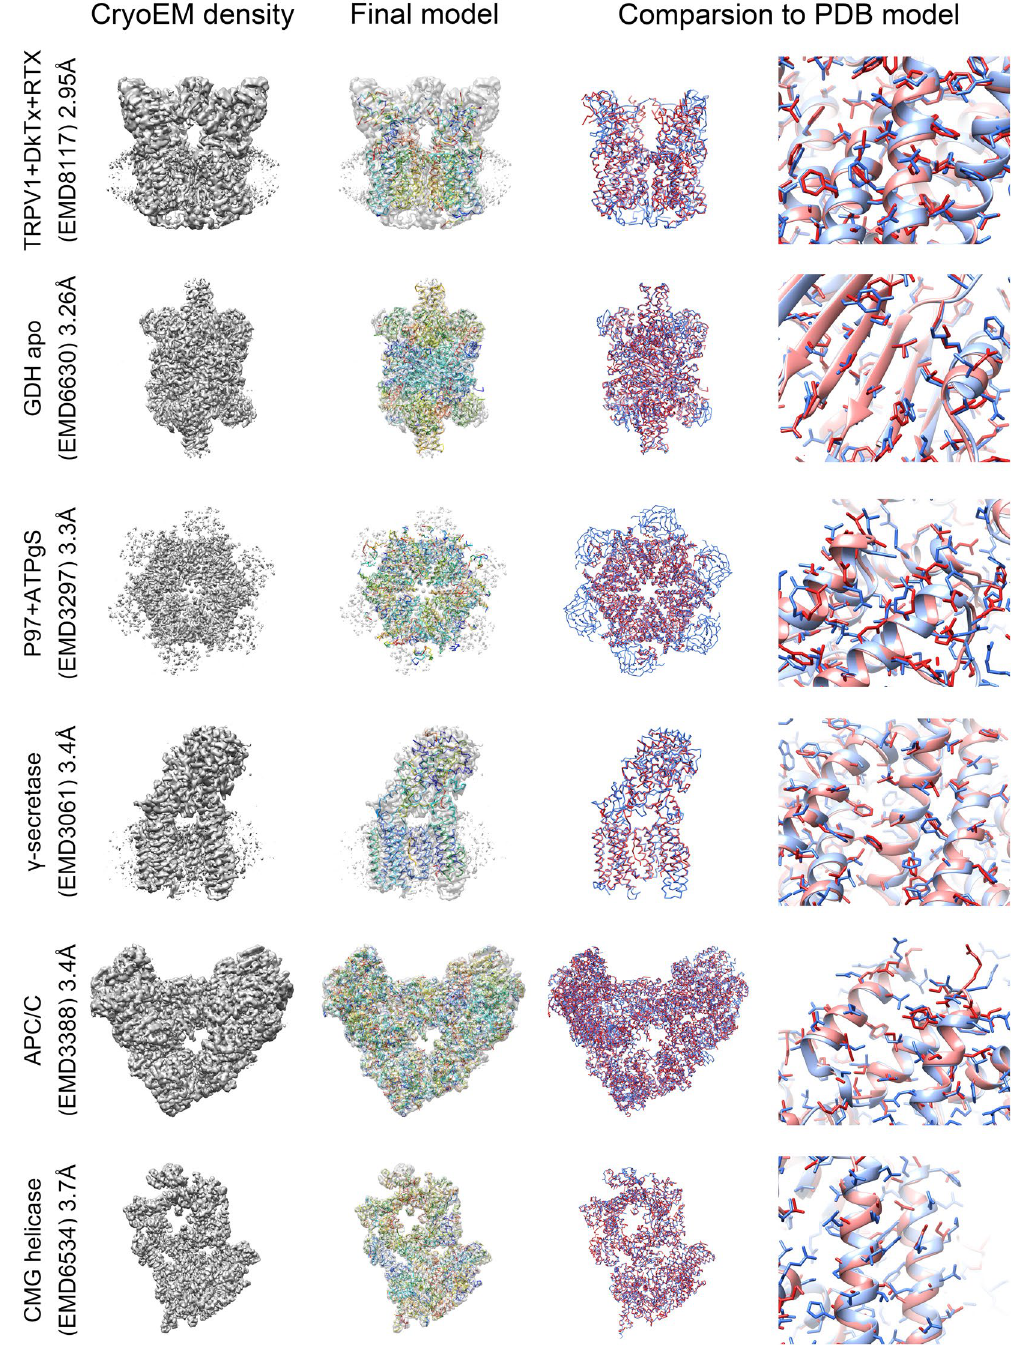
Figure 2. Model-building results from EMBuilder and comparison with PDB models. The cryoEM density map is presented in gray surface in the first column with a threshold from EMDB. Models built with EMBuilder are shown in the second column as cartoon representation. The overall comparison of the models built with EMBuilder (red ribbon) and the PDB models (blue ribbon) is presented in the third column. The side chain assignments of the models built with EMBuilder (red stick) and the PDB model (blue stick) are given in the fourth